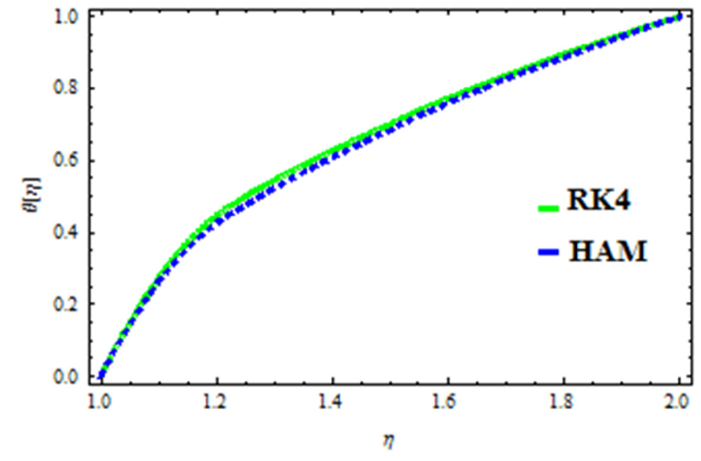
Figure 26. Comparison of RK4 and HAM for temperature in Reynolds’ model.